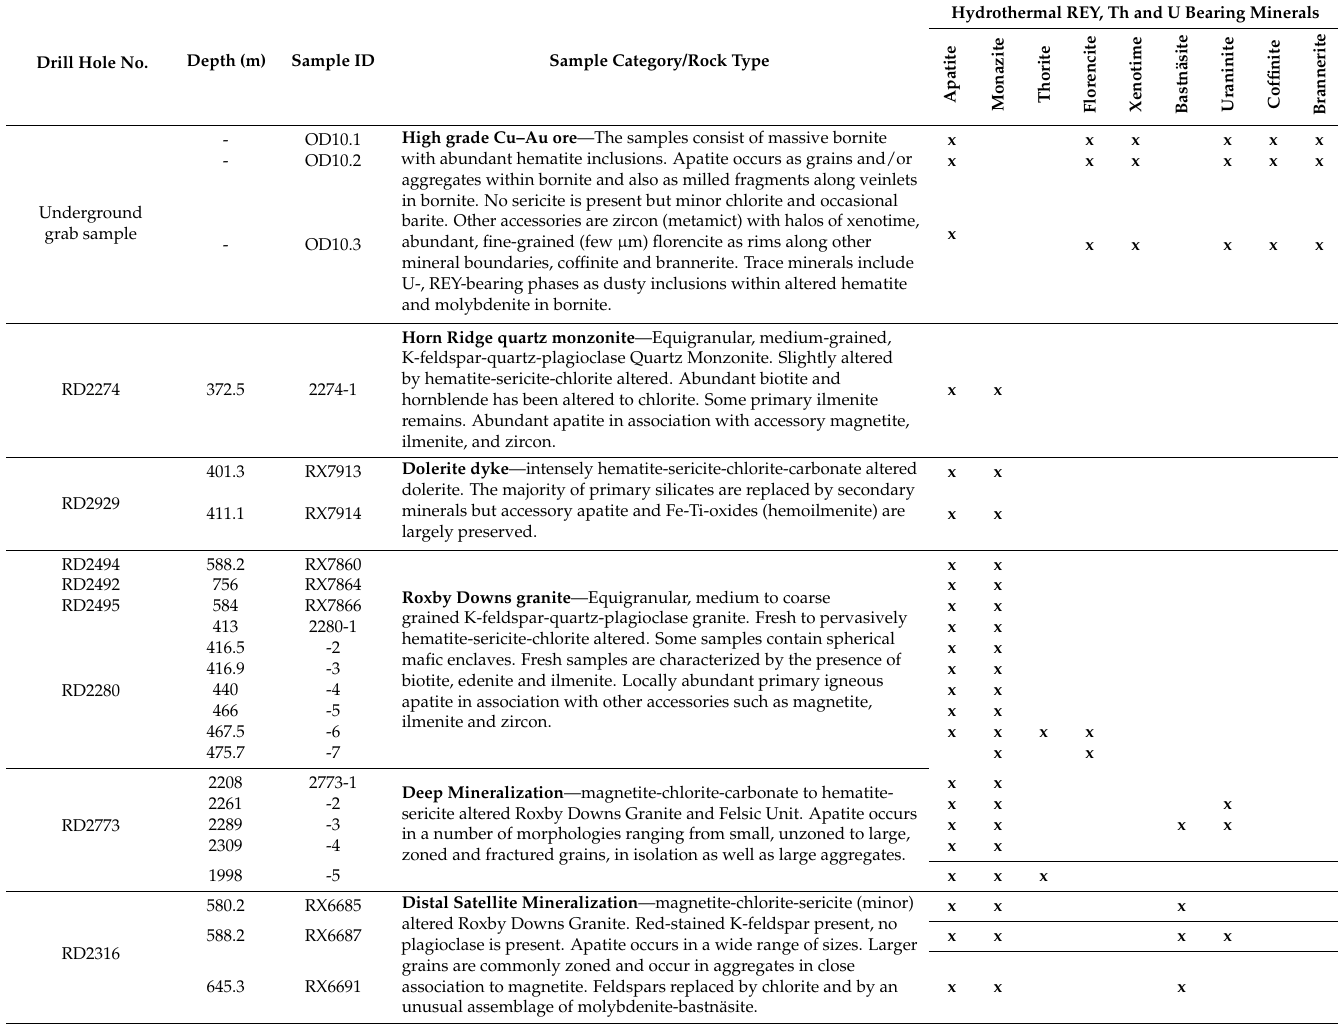
Table 1. Overview of lithologies and samples discussed in this